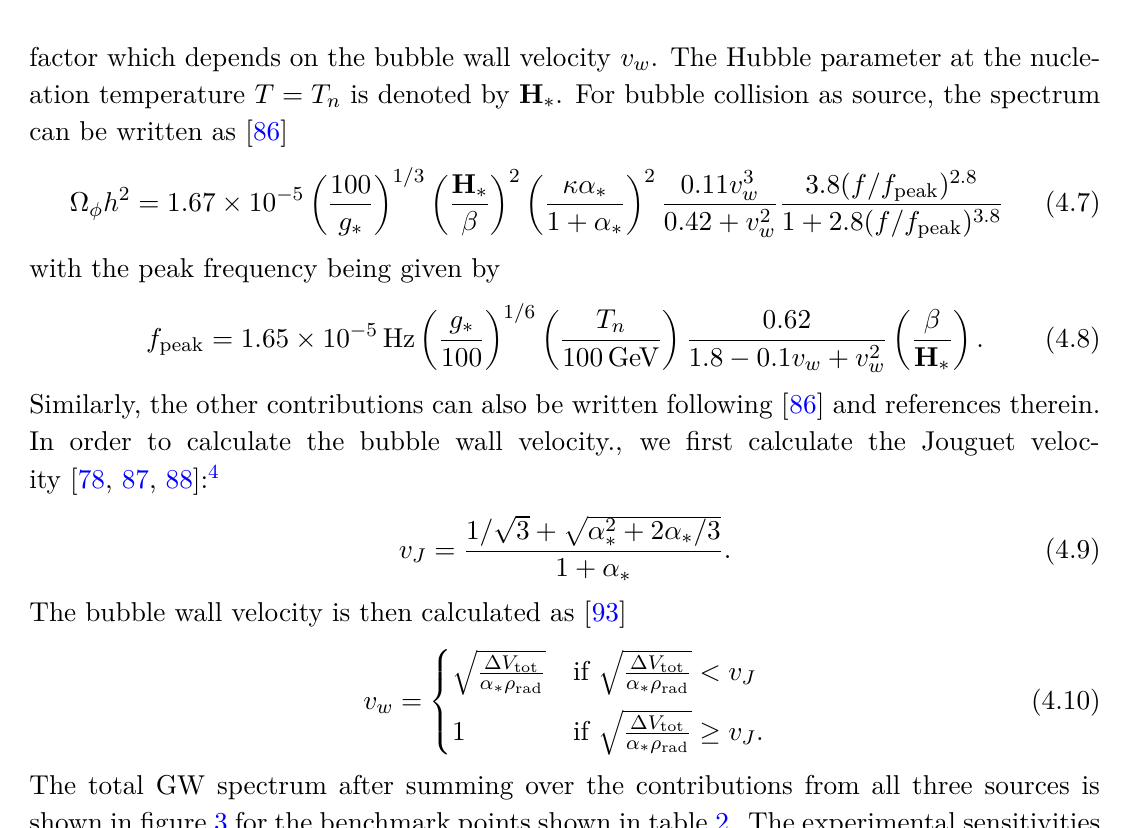
Figure 3 . Gravitational wave spectrum from FOPT in conformal scotogenic model for four different benchmark points given in table 2. Different coloured curves show the sensitivities from GW search experiments like LISA, BBO, DECIGO, HL (aLIGO), ET, CE, NANOGrav, SKA, GAIA, THEIA and µ